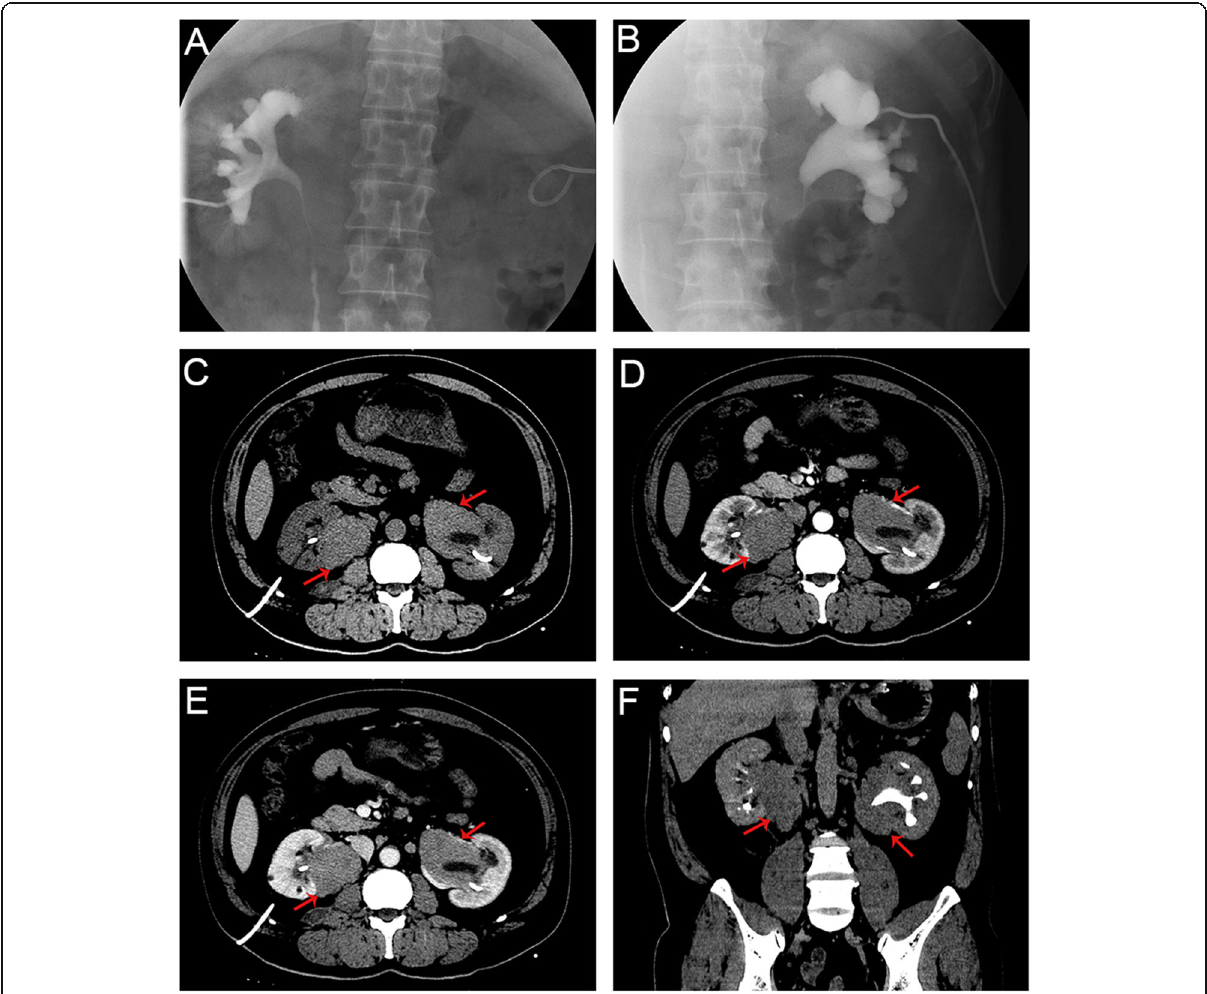
Fig. 3 The antegrade urography of the left (A) and right (B) kidney, and contrast-enhanced abdominal CT urography of the lesions (red arrow) during plain scan phase (C) , arterial phase (D) , venous phase (E) and delayed phase (F) in case